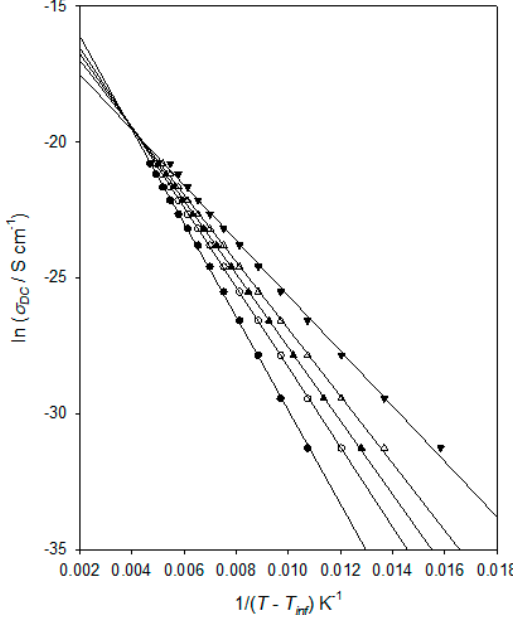
Figure 9. Analysis of the charge transport behaviour of the DGEBA/D–4000 system: T VFT σ = 160 K ( • ); T VFT σ = 170 K (o); T VFT σ = 175 K ( (cid:78) ); T VFT σ = 180 K ( (cid:52) ); T VFT σ = 190 K ( (cid:72)